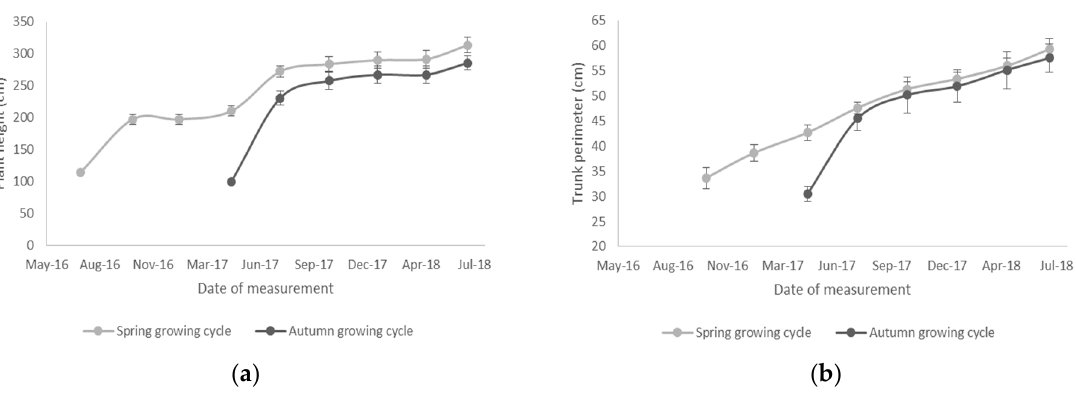
Figure 2. ( a ) Plant height and ( b ) trunk perimeter changes along the experiment in ‘Intenzza’ papayas planted in spring and autumn. Symbols represent mean values. Bars represent standard deviations. Figures represent growth according to date and not to plant age.